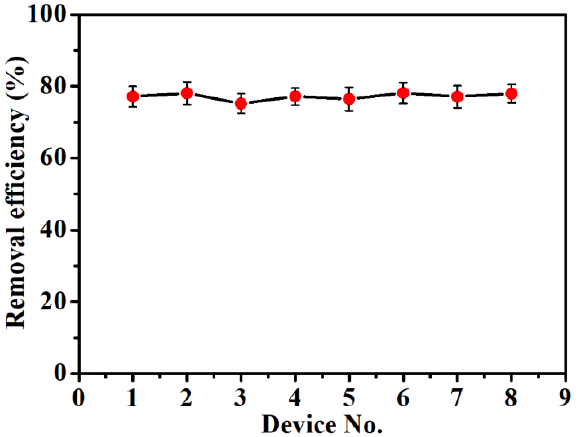
Figure 9. Removal efficiency measured for eight HAMA hydrogel-modified electrochemical devices in a solution of tap water with 400 µg/L Pb(II).